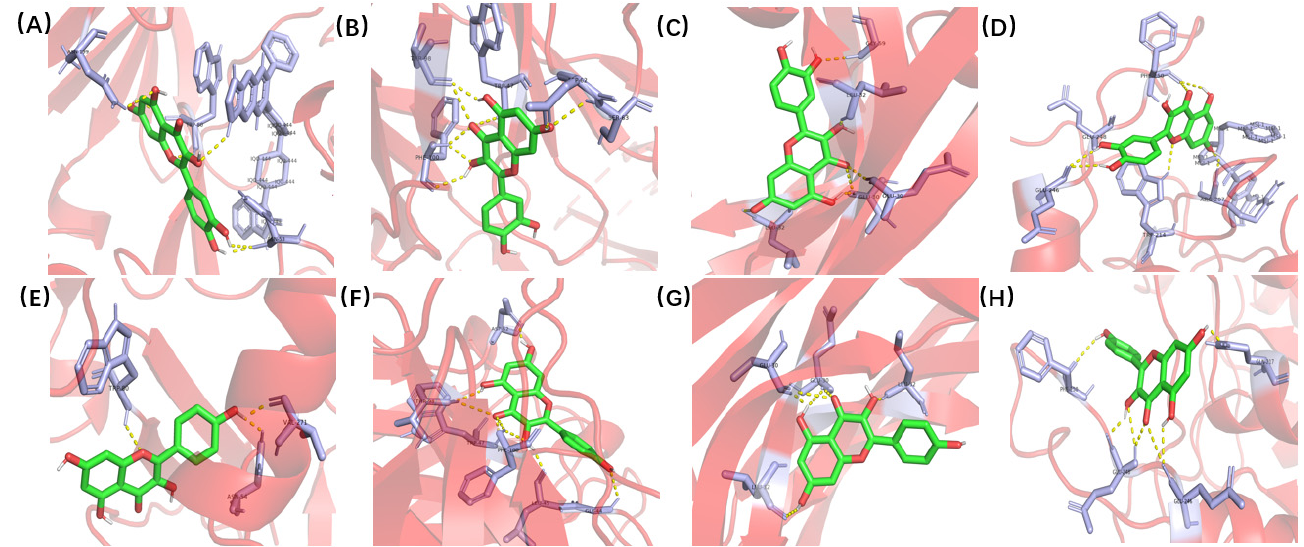
Table 3. Docking and binding energy of main components of Japanese Ardisia and core targets (kcal·mol − 1 ).